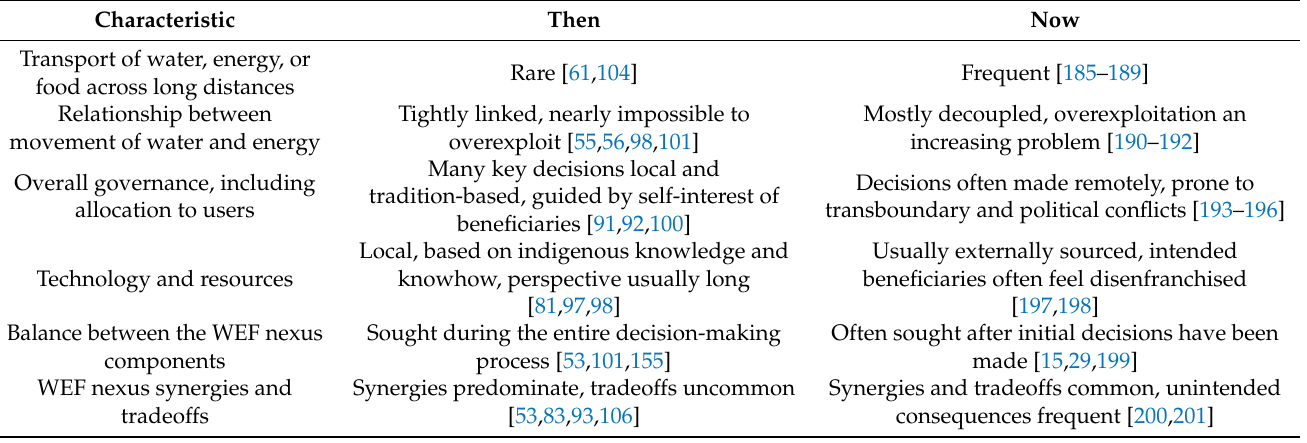
Table 2. Major characteristics of ancient and modern WEF